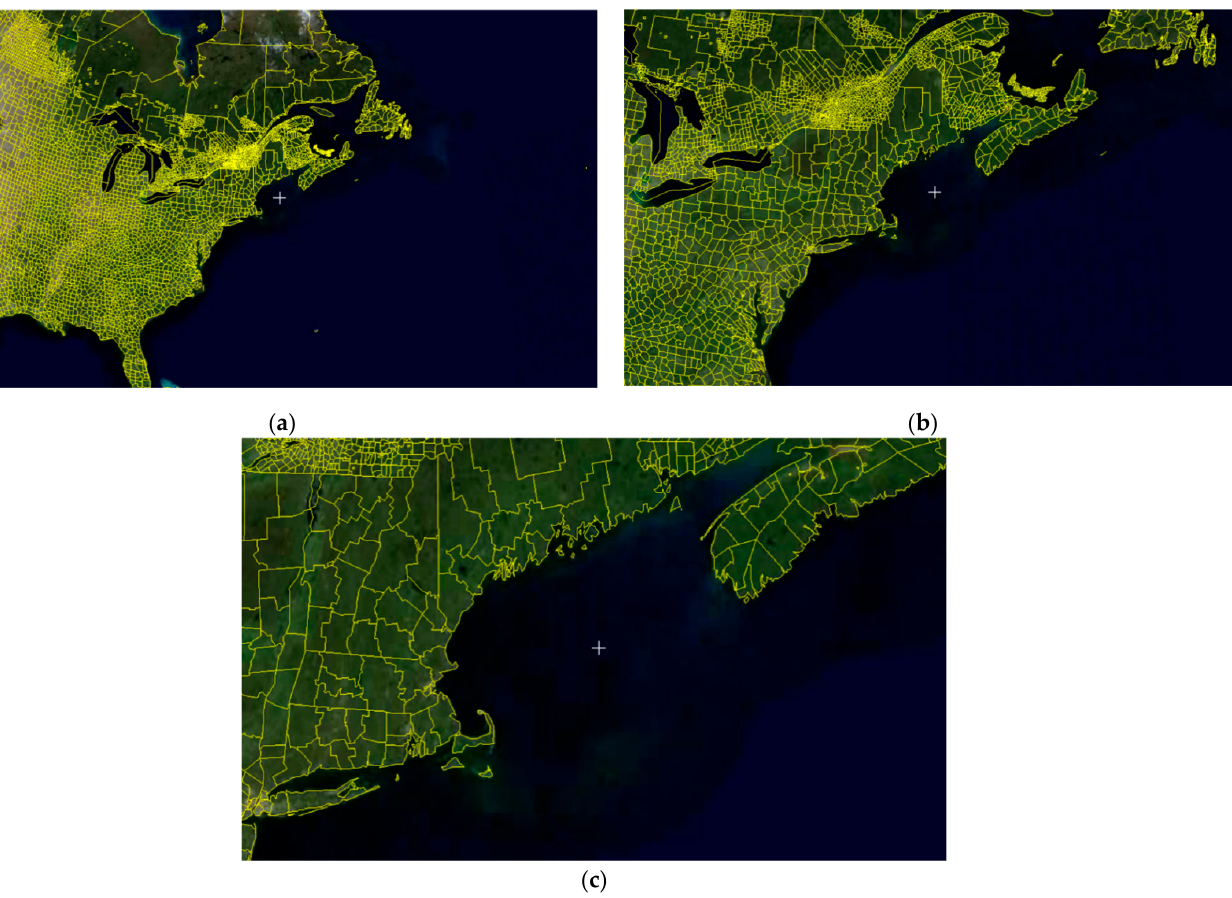
Figure 8. 3D visualization of the vector tiles at different levels of the VTPM. (a) When perspective of the 3D scene is fixed, the vector tiles are rendered. (b) When zoom in, more vector tiles are rendered. (c) When zooming in further, more and more vector tiles are rendered.